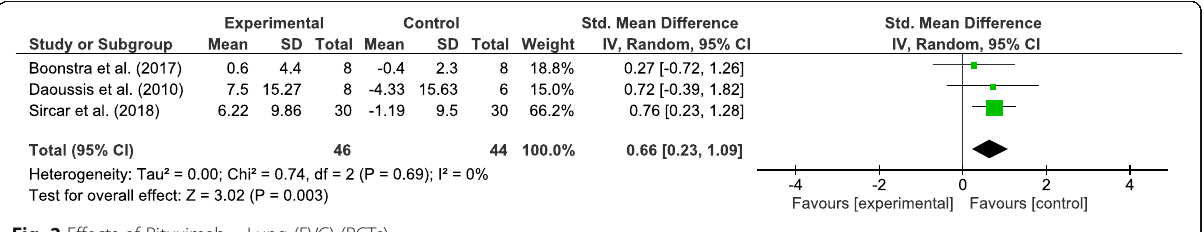
Fig. 2 Effects of Rituximab – Lung (FVC)